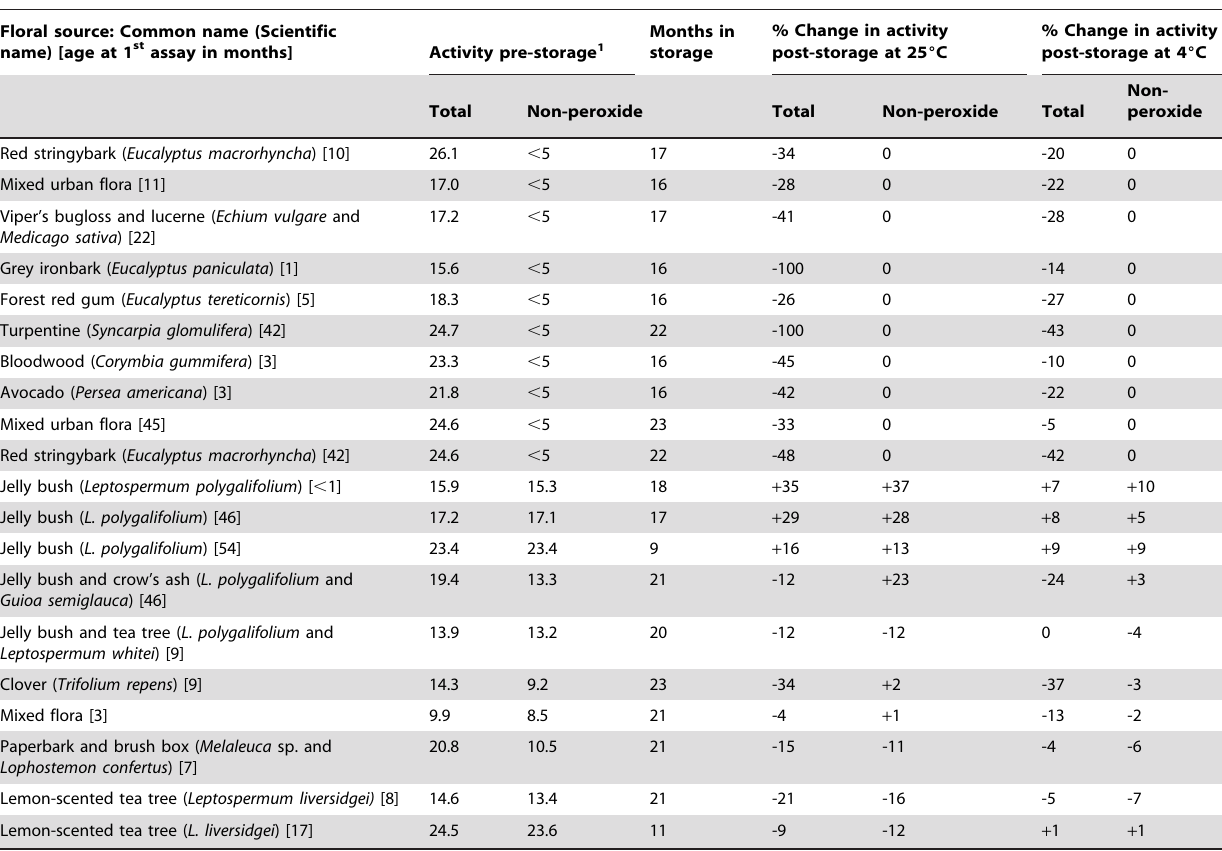
Table 4. Change in antibacterial activity of honey samples following storage.